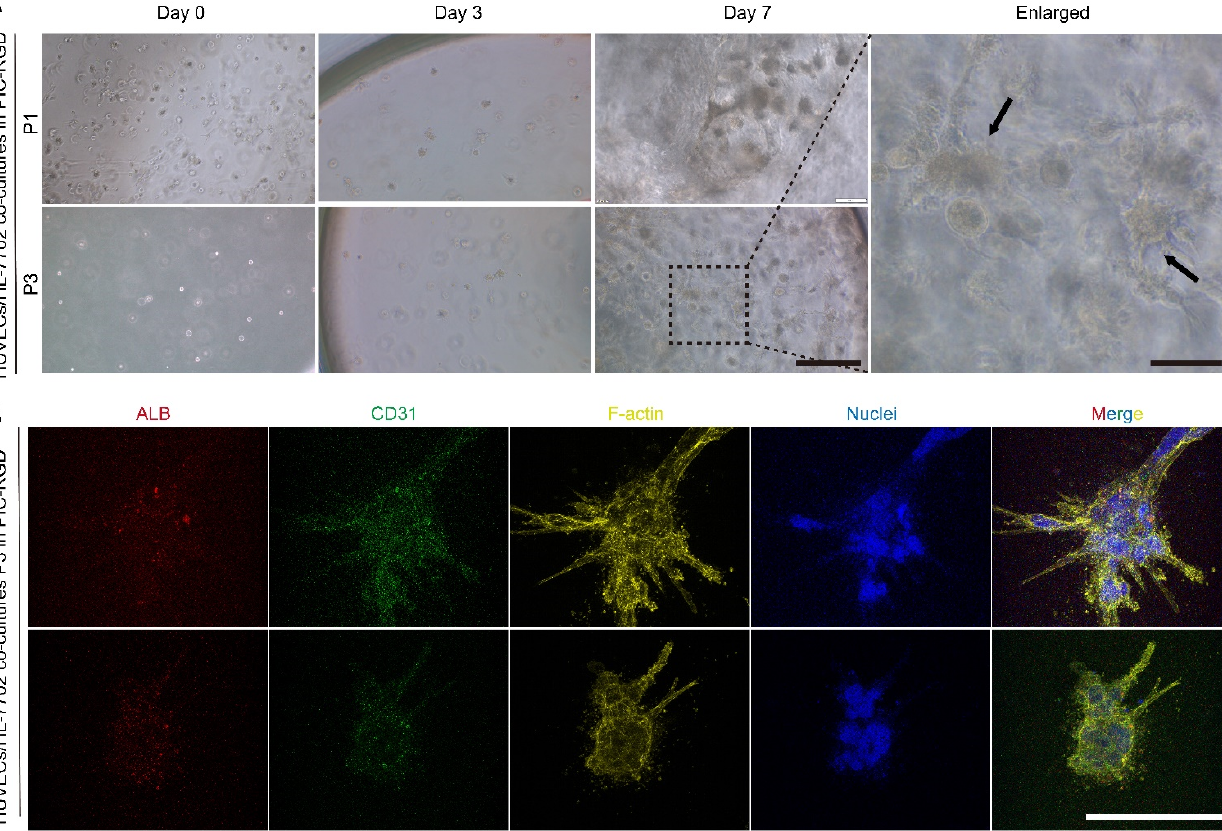
Figure 5. Co-culture of HUVECs with HL-7702 in PIC hydrogels. ( A ) HUVECs and HL-7702 cells were encapsulated in PIC-RGD and went through 7 days of culture and 3 rounds of passaging in PIC-RGD (scale bar = 200 μ m). The enlarged image represents the dashed area in A, and black ar- rows show the representative structure of co-culture that differs from the culture of HUVECs alone (scale bar = 50 μ m). ( B ) Fluorescence staining of co-culture in PIC-RGD shows good maintenance of cellular properties after 3 rounds of passaging in PIC-RGD. ALB: in red, HL-7702 maker; CD31: in green, EC maker; phalloidin: in yellow, stains F-actin, and Hoechst 33342: in blue, stains cell nuclei (scale bar = 50 μ m). ( C ) Percentage of ALB and CD31 positive cells in four fields of vision. ( D ) TUNEL assay (red) with Hoechst 33342 staining (blue, cell nuclei) and bright field image of P3 co- culture of HUVECs and HL-7702 after 7 days in culture in PIC-RGD show few apoptotic cells in co- cultures (scale bar = 200 μ m). ( E ) Percentage of TUNEL negative cells per field of vision. For all samples, the PIC-RGD concentration c = 1 mg mL − 1 and the initial cell density is 200,000 cells mL − 1 for mixed cells, and 100,000 cells mL − 1 for each kind of cell, respectively. N/A represents not appli- cable data, since plain PIC does not support HUVECs/HL-7702 co-culture.